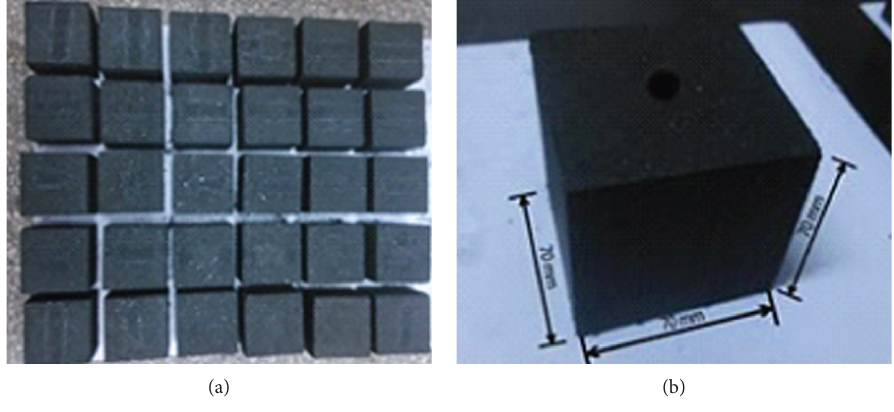
Figure 3: Briquette coal samples for